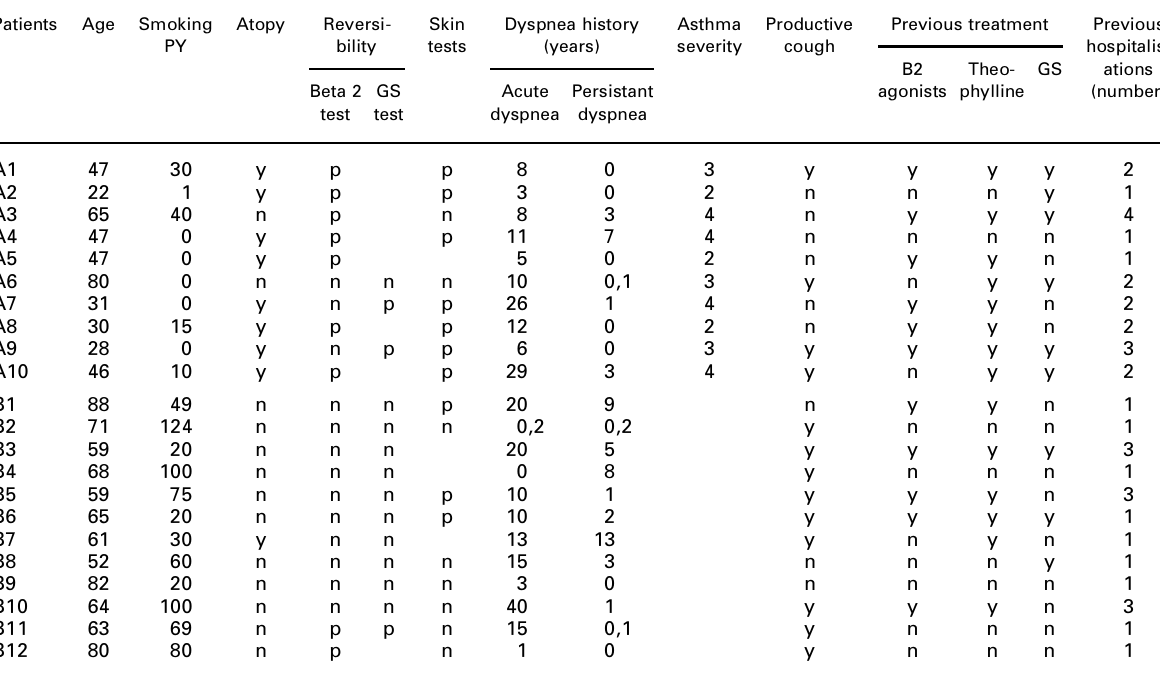
Table 1. Clinical manifestations and treatment. A: asthma; B: COPD; PY: pack year; GS: glucosteroids; y: yes; n: negative results; asthma severity: 2: mild, 3: moderate, 4: severe. Patients Age Smoking PY